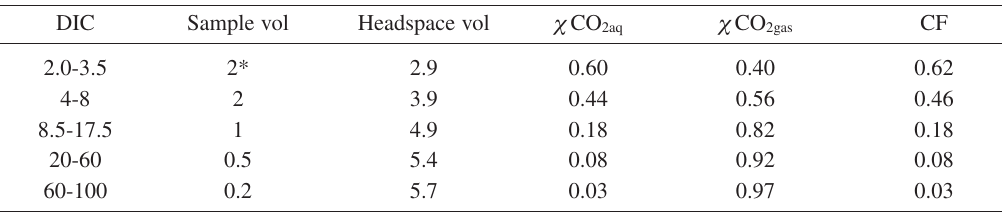
Table I. Computed Correction Factor (CF) as a function of the DIC content and the volume of water injected for vials with internal volume of 5.9 ml. DIC contents of water samples ([CO 2aq ] + [HCO 3 − ] + [CO 3 −− ]) are ex- pressed in mmol/l. Sample volume is expressed in milliliter. The molar fraction of dissolved CO 2 ( χ CO 2aq ) has been calculated by Henry’s law. For DIC contents between 2 and 3.5 mmol/l, CF was computed considering the reduced headspace volume due to the insertion of the glass cylinder (see